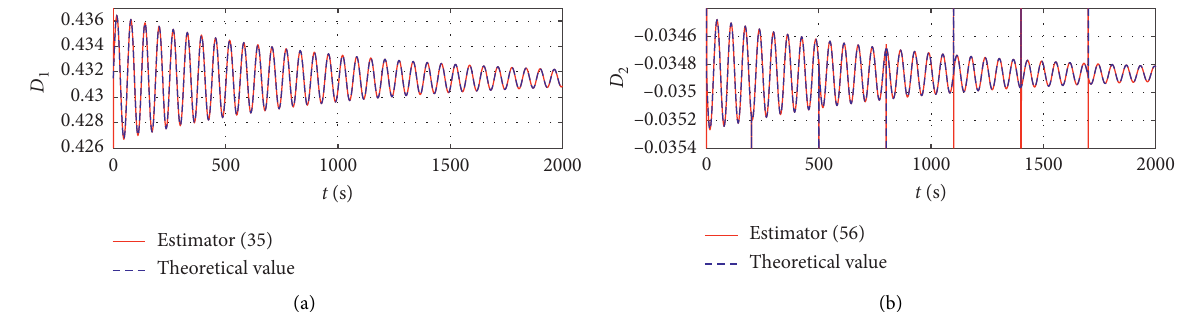
Figure 10: Estimation result of the unknown dynamics D